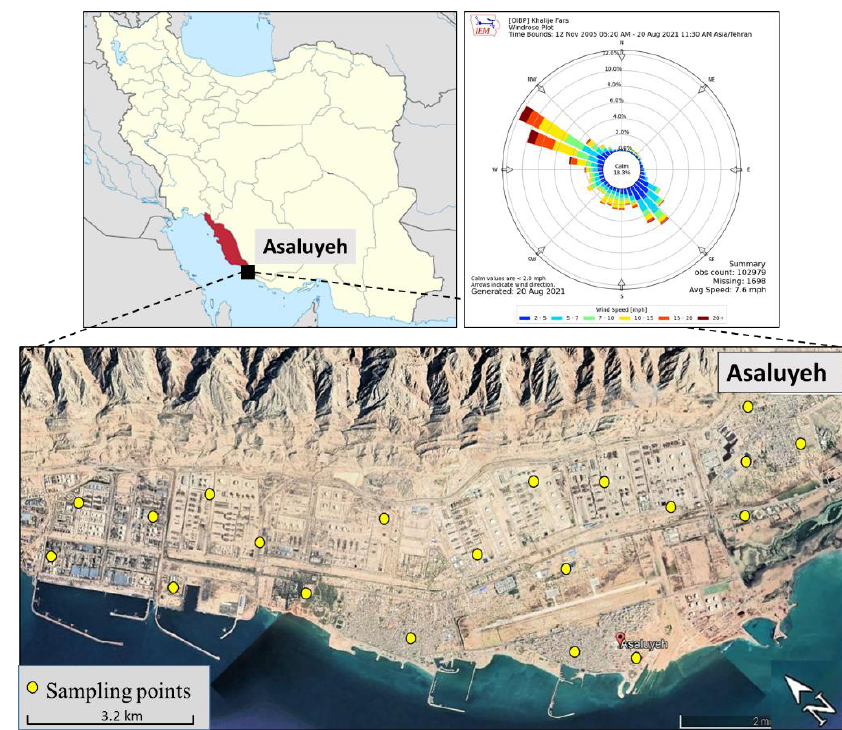
Figure 1. District distribution map of the Bushehr province in south Iran and the Asaluyeh county ( top left ) and the locations of the sampling points (houses) in Asaluyeh ( bottom ), along with wind rose diagram during the sampling days ( top right ).